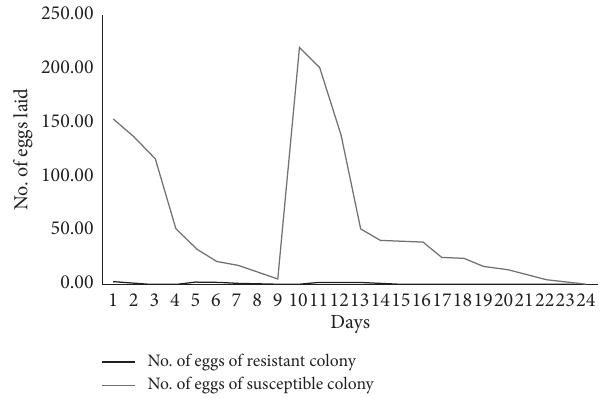
Figure 6: The egg batch sizes of Kisumu susceptible strain ( An. gambiae s.s.) and ( An. gambiae s.l . ) wild resistant